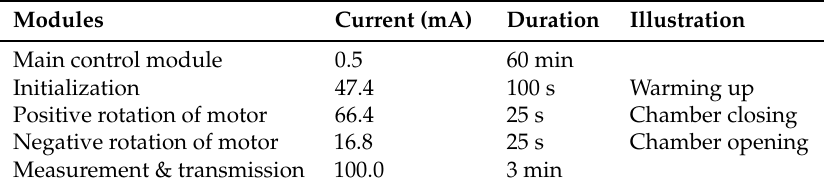
Table 2. Energy Consumption of SCFSen